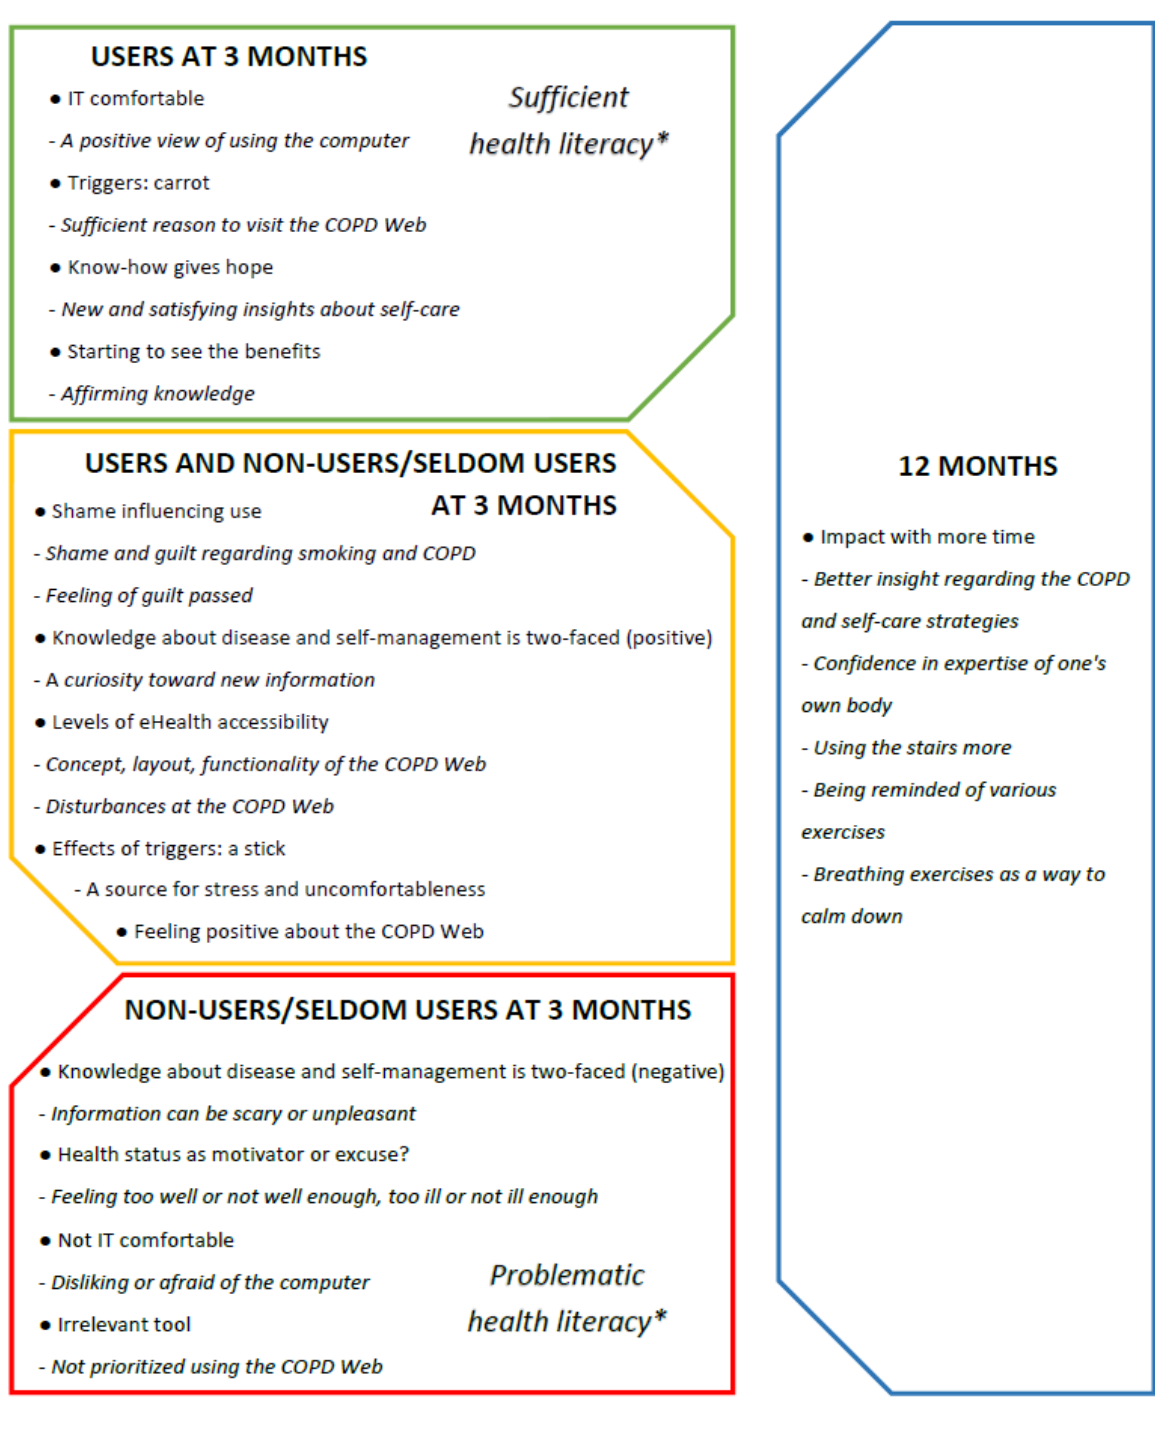
Figure 1. Overview of user experience and factors affecting usage. “Users at three months” represent experiences mainly seen among those who used the COPD Web during the initial three months, “Non-user/seldom-users at three months” represent experiences mainly seen among those who did not use, or used at a limited extent, the COPD Web at three months, “Users and non-user/seldom-users at three months” represents experiences seen among both users and non-user/seldom-users at three months while “12 months” represents experiences mainly expressed at 12 months. *Based on the communicative and critical health literacy scale, Swedish